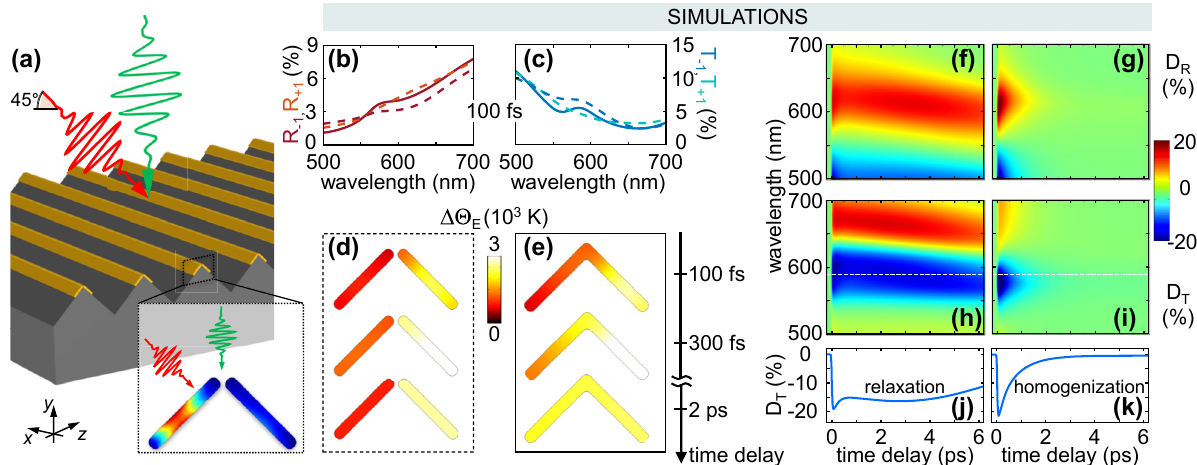
Figure 7: Design of a plasmonic metagrating for ultrafast diffraction management. (a) Sketch of the plasmonic metagrating, consisting of a 1D array (with a periodicity of 800 nm) of cross-polarized Au nanostrip meta-atom dimers (each strip being 165 nm in length and 22.5 nm in width). A linearly-polarized pump pulse at 600 nm impinging at 45 ◦ (red) and a broad probe pulse at normal incidence (green) are considered. The inset displays the absorption pattern at 50 fs time delay across the meta-atom. (b and c) First-order transient reflection R ± spectra at 100 fs time delay (dashed lines), compared with static (degenerate) spectra (solid lines). (d and e) Spatial distribution of the electronic temperature increase in the disconnected dimer nanostrip (d) and the connected variant (e) at selected time delays. (f–k) Maps of the D (h, i) figures of merit, together with the D dynamics at 590 nm (j, k) for the disconnected (f, h, j) and connected (g, i, k) nanostrip meta-atom T configurations. Adapted with permission from ref. [222]. Copyright 2020 Author(s), licensed under a CC-BY Creative Commons Attribution 4.0